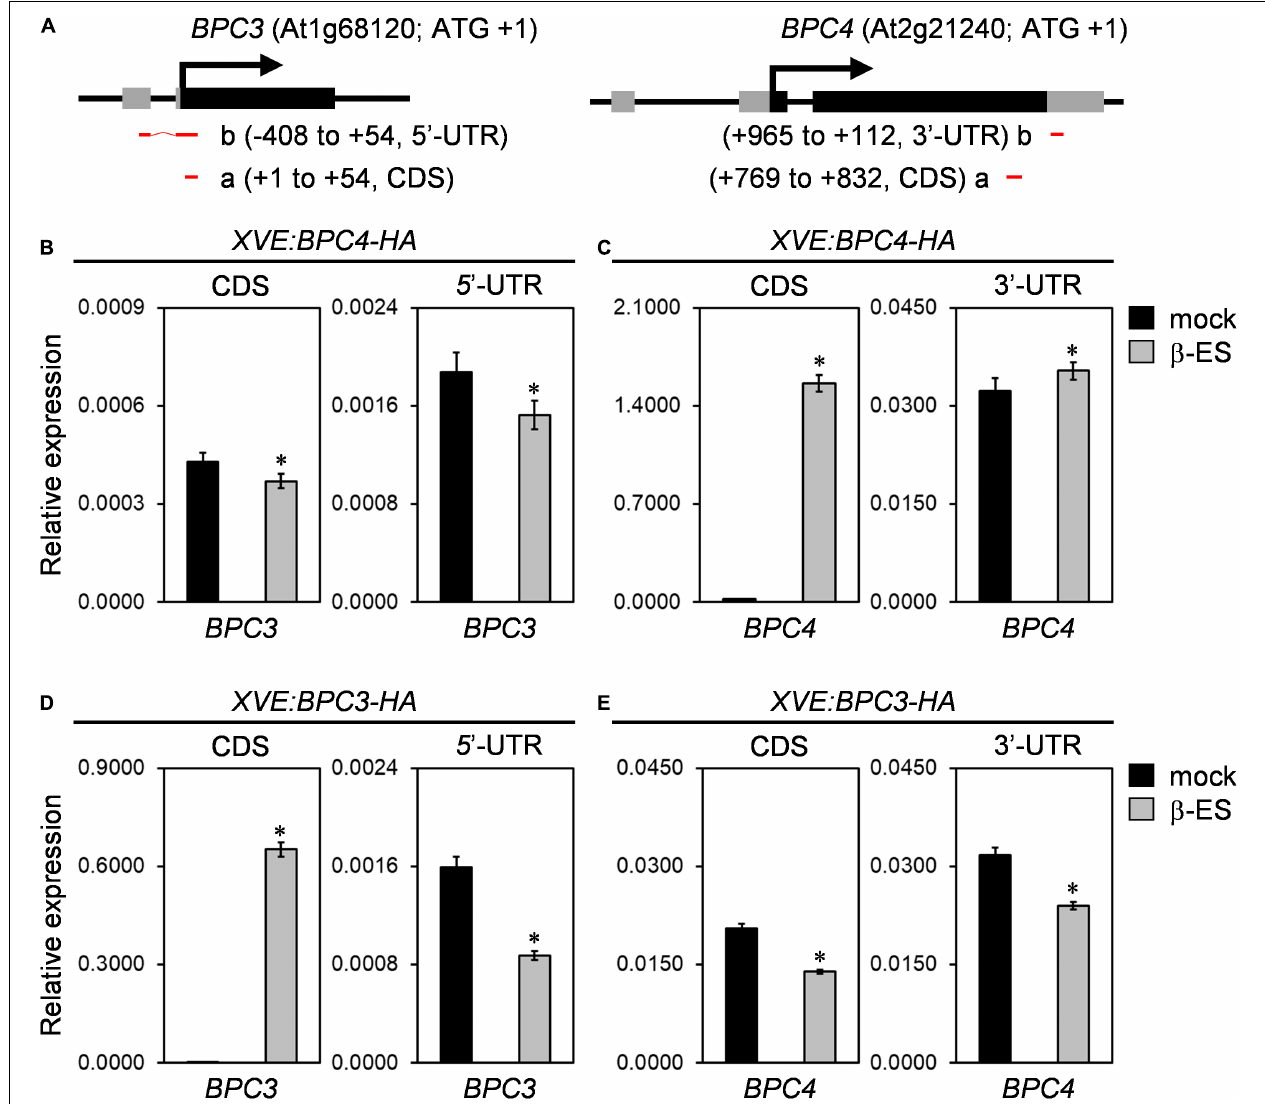
FIGURE 3 | BPC members are mutually antagonized. (A) Diagrams of gene structures of BPC3 (left panel) and BPC4 (right panel). Translational start and exons are marked with arrows and boxes. Black and gray boxes illustrate the coding region sequence (CDS) and untranslated regions (UTR). Red horizontal bars “a” and “b” illustrate amplicons of qPCR. Numbers denoted in parentheses are positioned relatively to translation start site + 1 for amplicons at CDS or UTR. The illustrated BPC3 5 (cid:48) -UTR of the gene structure is revealed by the EST clone “M44A7” but not shown in the gene model of TAIR10. (B–E) The inducible lines of XVE:BPC4-HA (B,C) and XVE:BPC3-HA (D,E) were treated with 0 (mock) or 50 µ mM 17- β -estradiol ( β -ES) for 24 h and harvested every 3 h for the next day. The transcription levels of BPC4 (C,E) and BPC3 (B,D) relative to that of UBQ10 were analyzed by qRT-PCRs with amplicons located at the indicated CDS or UTR. Data are mean ± S.E. ( n = 27, each data includes 3 technical repeats of 9 biological replicates collected every 3 h across the second day after induction; corresponding individual time points and an independent biological replicate are presented in Supplementary Figure 5 ). Asterisks indicate transcript levels were significantly changed by β -ES treatments (Student’s t- test; ∗ P <